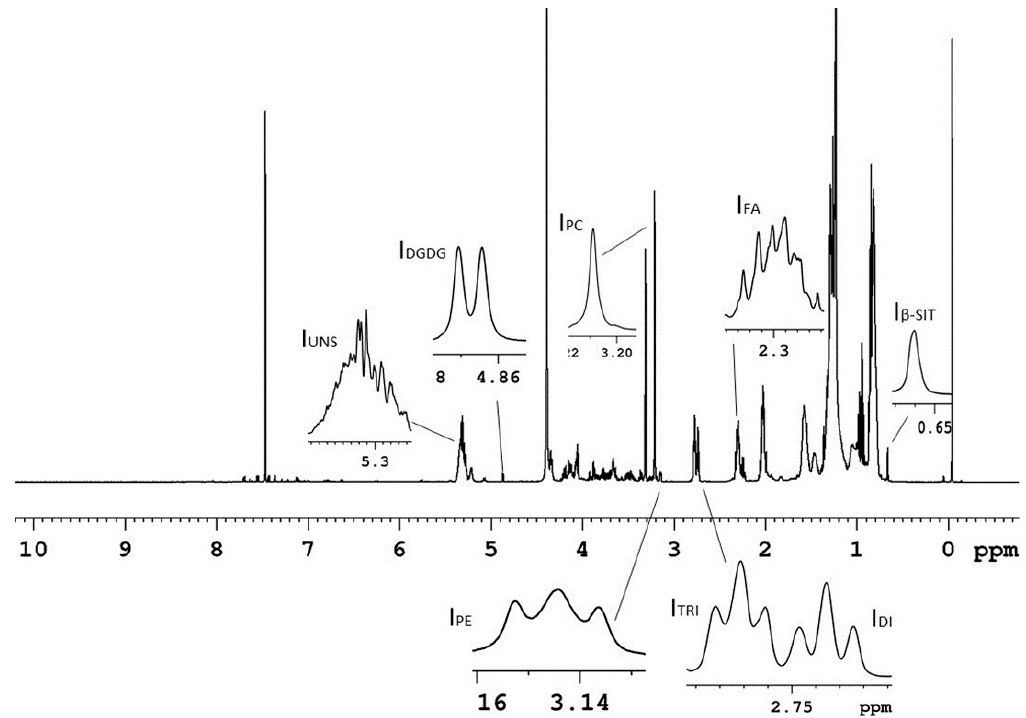
Figure 3. 600 MHz 1 H NMR spectrum (28 °C) of potato organic Bligh–Dyer extract dissolved in CDCl 3 /CD 3 OD (2:1 v/v ) mixture. Signals used for the quantitative analysis were labelled: I β -SIT , CH 3 -